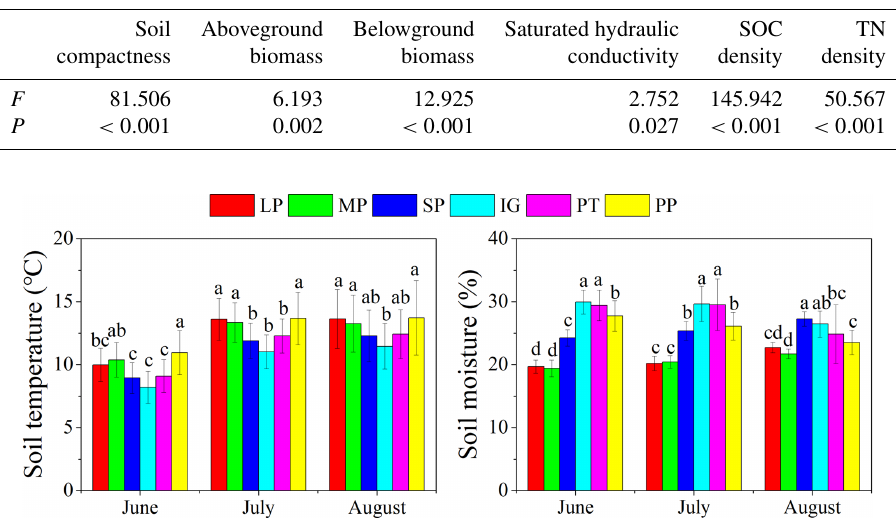
Table 2. ANOVA results of soil compactness, aboveground biomass, belowground biomass, soil hydraulic conductivity, and SOC and TN density in different land surface types.